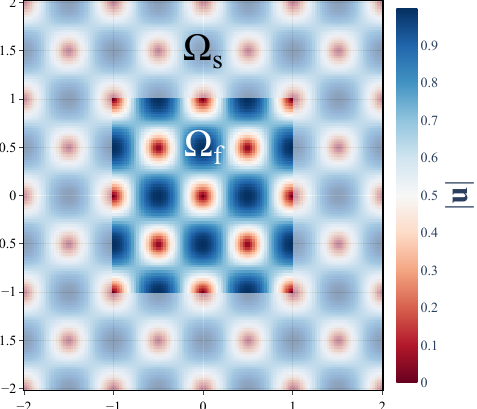
Figure 6. Schematics of the computational domain in the decaying vortex problem. In Ω s , velocity and pressure fields are prescribed according to Equation (28). The solution in region Ω f is predicted numerically. The initial field of velocity magnitude is shown by the